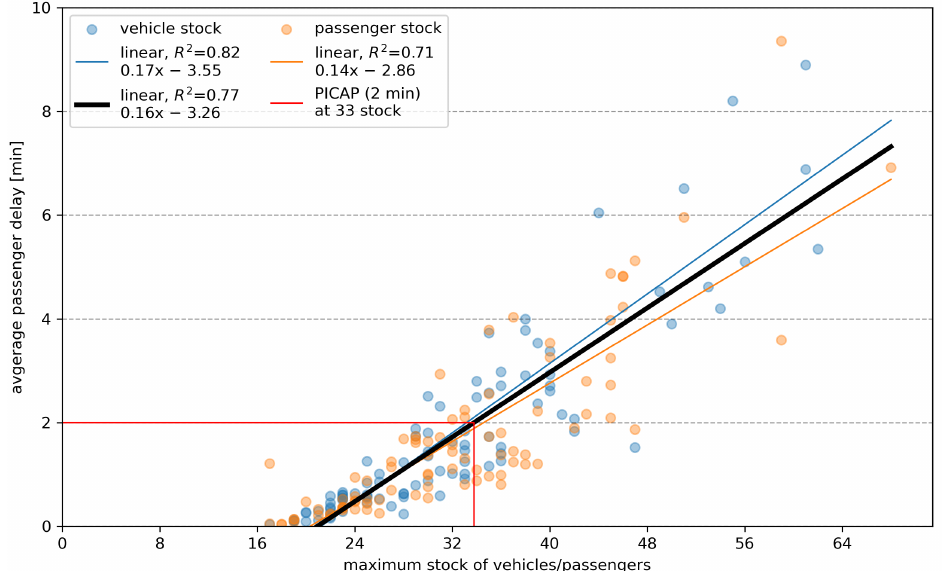
Figure 7. Analyzing the effect of vehicle/passenger stock on the average passenger delay and identification of the practical imbalance capacity PICAP.